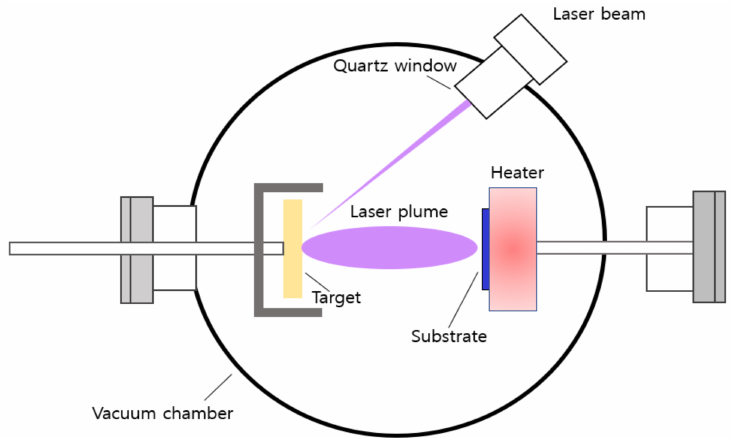
Figure 2. Schematic diagram of a PLD